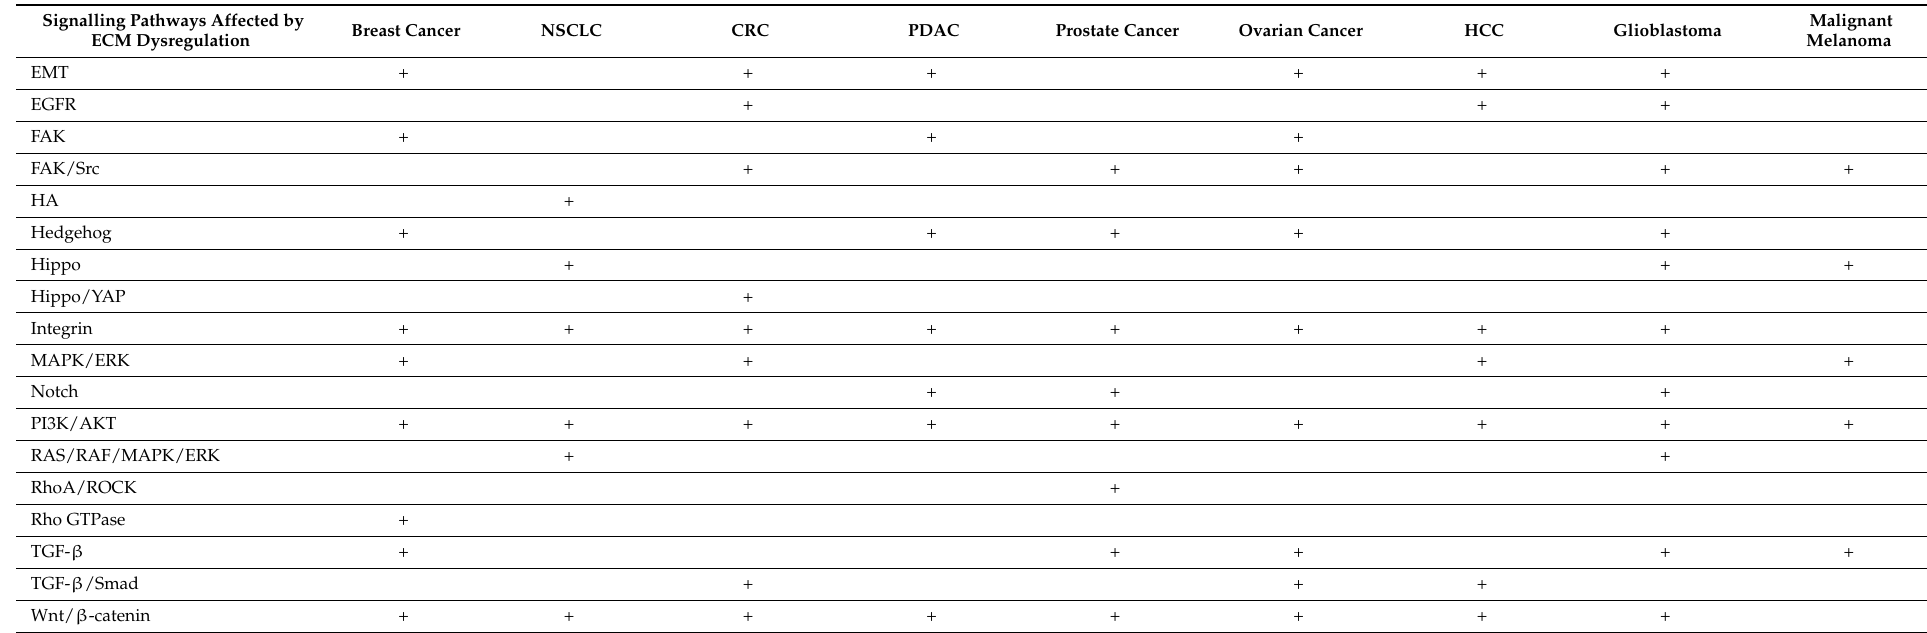
Table 2. A non-exhaustive table summarising the expression levels of some of the main signalling pathways in various solid cancers that are affected by ECM dysregulation, such as aberrant collagen deposition, increased HA expression, and abnormal expression of laminin and fibronectin. It is important to note that the expression levels of signalling pathways may vary. They are not mutually exclusive, and as shown, they often overlap and interact with each other. Signalling pathways are also affected by the accumulation of genetic mutations and disease progression and may change their oncogenic drive. With progression, changes in the composition and organisation of the ECM may affect additional pathways. For example, in early-stage breast cancer, changes in collagen I and IV deposition can activate the PI3K/AKT and MAPK/ERK pathways, whereas in advanced stages, the deposition of different types of collagens, such as collagen VI, can activate the TGF- β pathway. Similarly, in lung cancer, the expression of hyaluronan is increased in advanced stages, leading to dysregulation of the Hippo pathway, which promotes tumour growth and metastasis. CRC: colorectal cancer, EMT: epithelial-mesenchymal transition, EGFR: epidermal growth factor receptor, ERK: extracellular signal-regulated protein kinase, FAK: focal adhesion kinase, HA: hyaluronic acid, HCC: hepatocellular carcinoma, MAP/ERK: microtubule- associated protein kinase; MAPK: mitogen-activated protein kinase, NSCLC: non-small cell lung cancer, PDAC: pancreatic ductal adenocarcinoma,